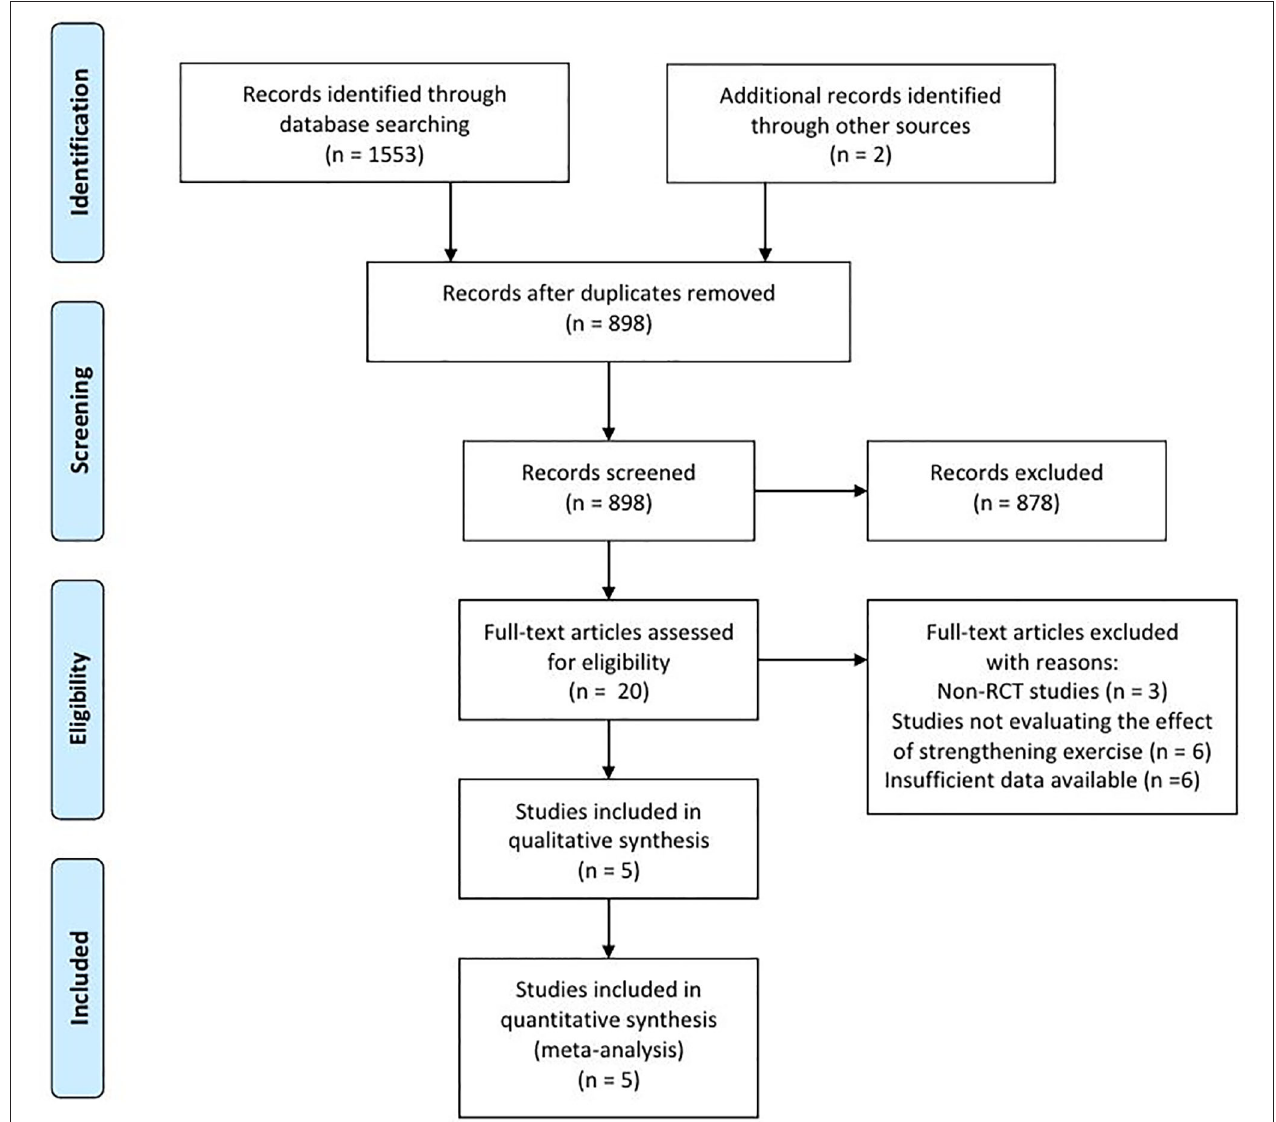
FIGURE 1 | Flow diagram of study